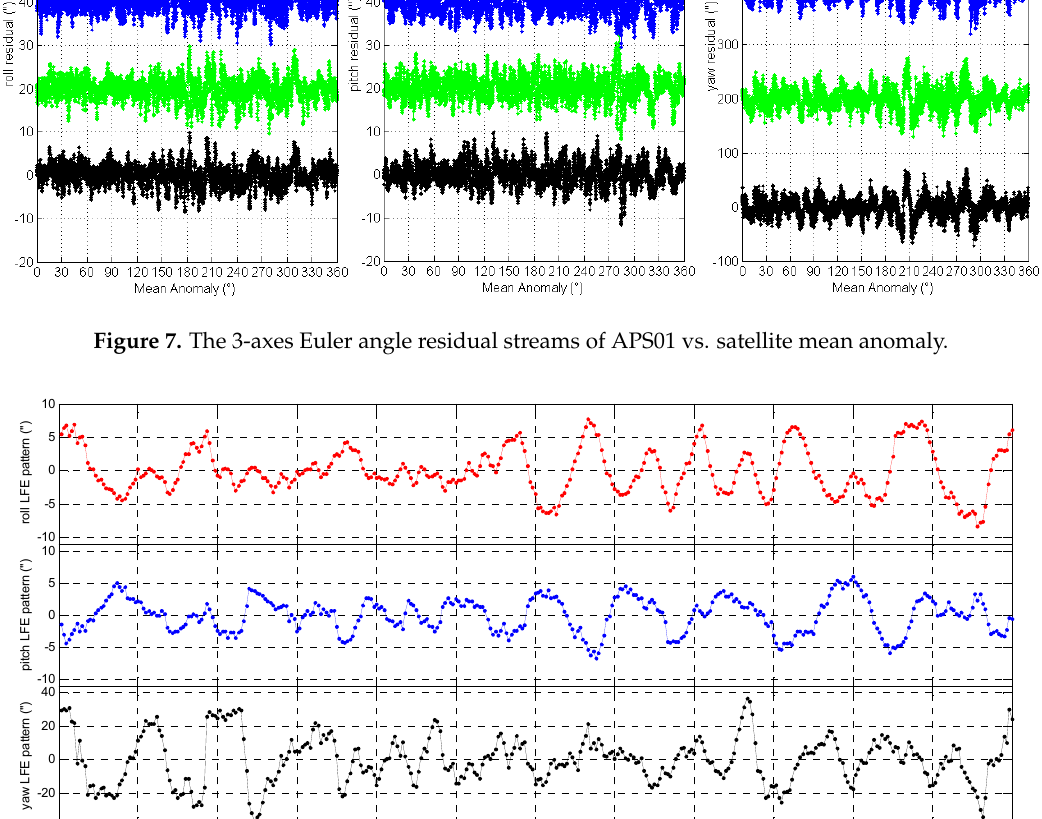
Figure 7. The 3-axes Euler angle residual streams of APS01 vs. satellite mean anomaly.